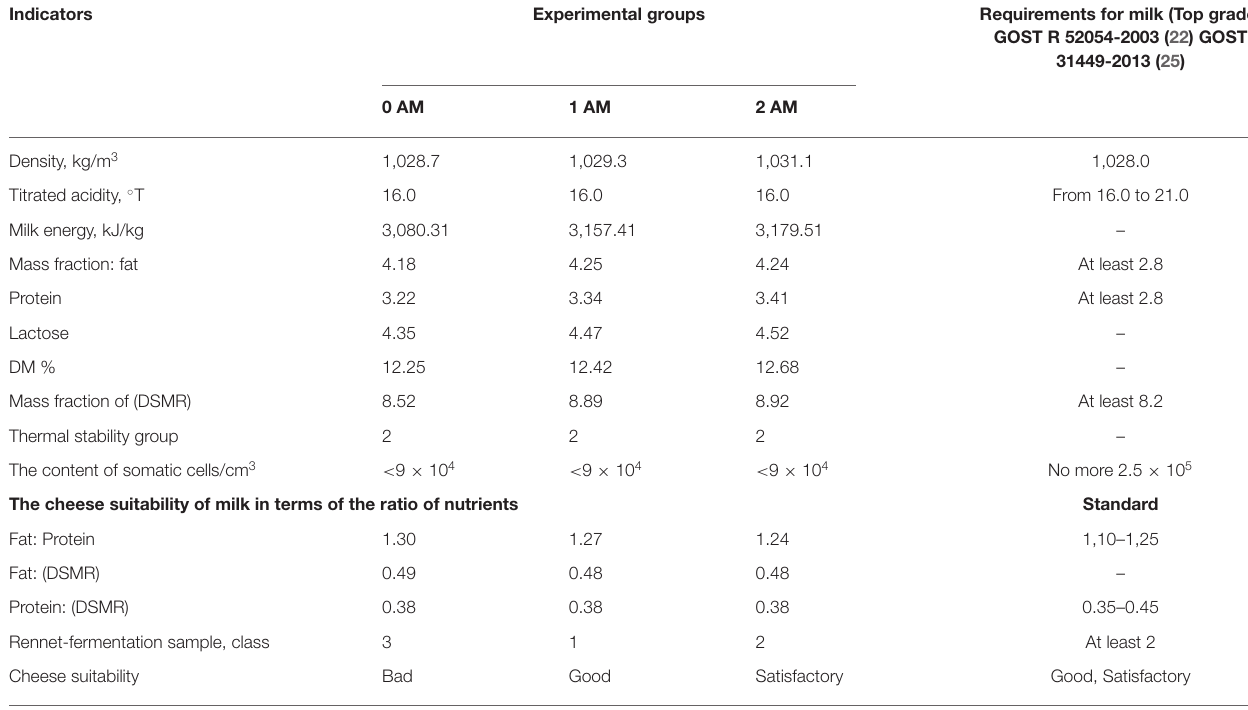
TABLE 7 | Physicochemical composition and quality indicators of milk of experimental cows during the period of lactation % (15 head/group). Indicators